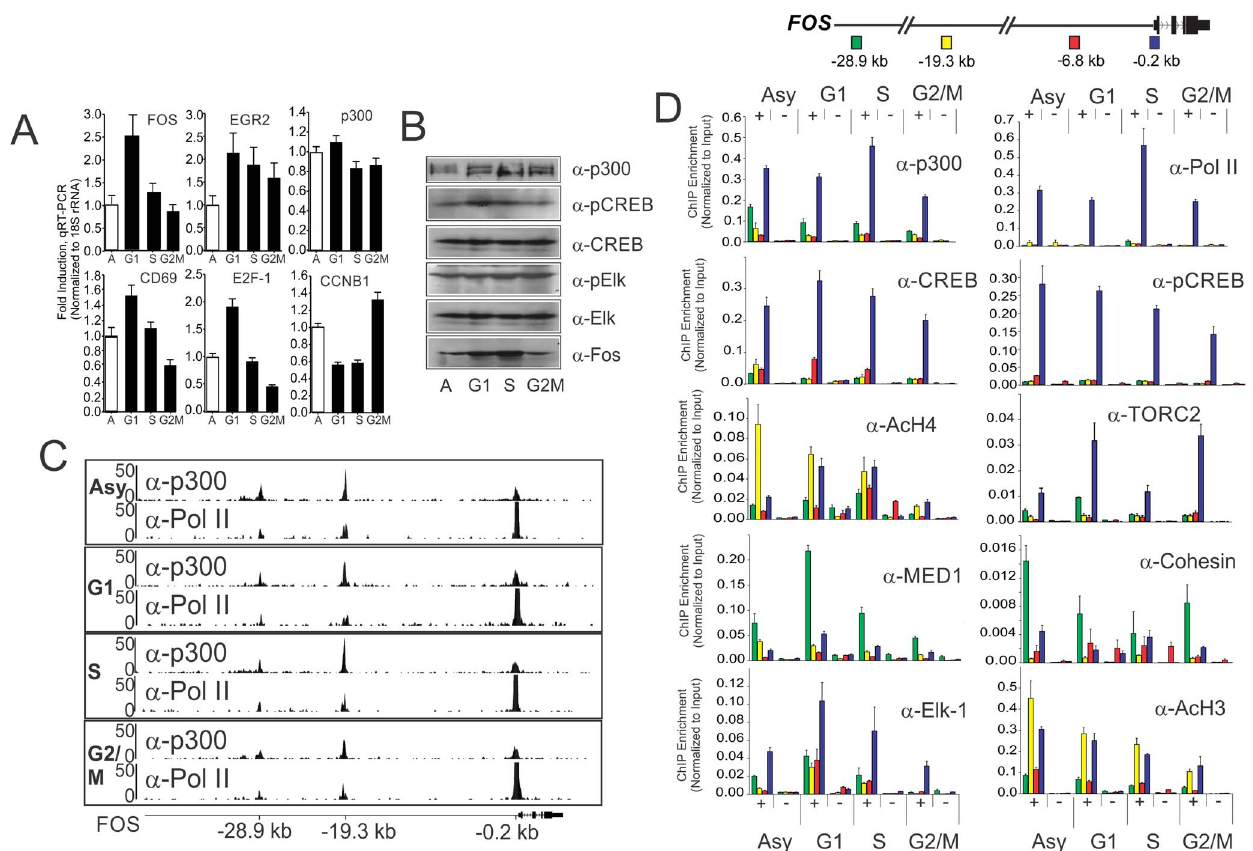
Figure 2. A pre-initiation complex containing p300 remains assembled at the FOS promoter and distal enhancers throughout the cell cycle. Jurkat cells were elutriated to obtain populations of cells at different stages of the cell cycle. (A) qRT-PCR profile showing expression of immediate early genes peaks at the G1 phase of the cell cycle. The fold induction present at each phase (G1, S and G2/M) is presented as relative level compared to the amount present at the asynchronous phase (A) Error bars represent standard error of the mean from 4 biological replicates each determined in triplicate. (B) Western blots showing protein levels of p300, total and phospho-CREB, total and phospho-Elk and FOS at different stages of the cell cycle. Shown is 1 of 3 independent biological replicate of elutriations. (C) ChIP-Seq profiles of the binding of p300 and pol II at the FOS promoter and distal enhancers. Shown is 1 of 2 independent biological replicate of elutriations. (D) Position dependent profile at the FOS locus for indicated antibodies ( + ) and no antibody control ( 2 ) as indicated determined by quantitative ChIP analysis throughout the cell cycle. Error bars represent standard error of the mean from 3 or 4 biological replicates each determined in duplicate. Above is shown a schematic of the locations of enhancers ( 2 28.9 kb & 2 19.3 kb), upstream ( 2 6.8 kb) and promoter ( 2 0.2 kb) at the FOS locus relative to TSS as